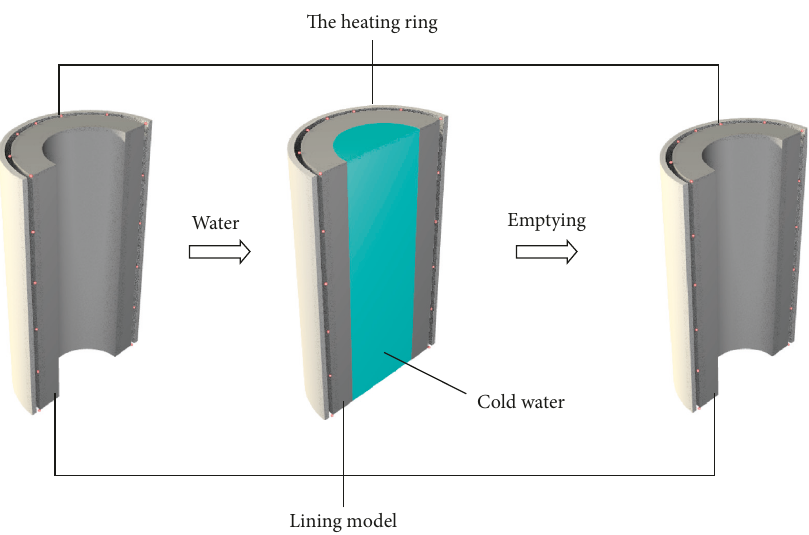
Figure 7: Process of experiment.